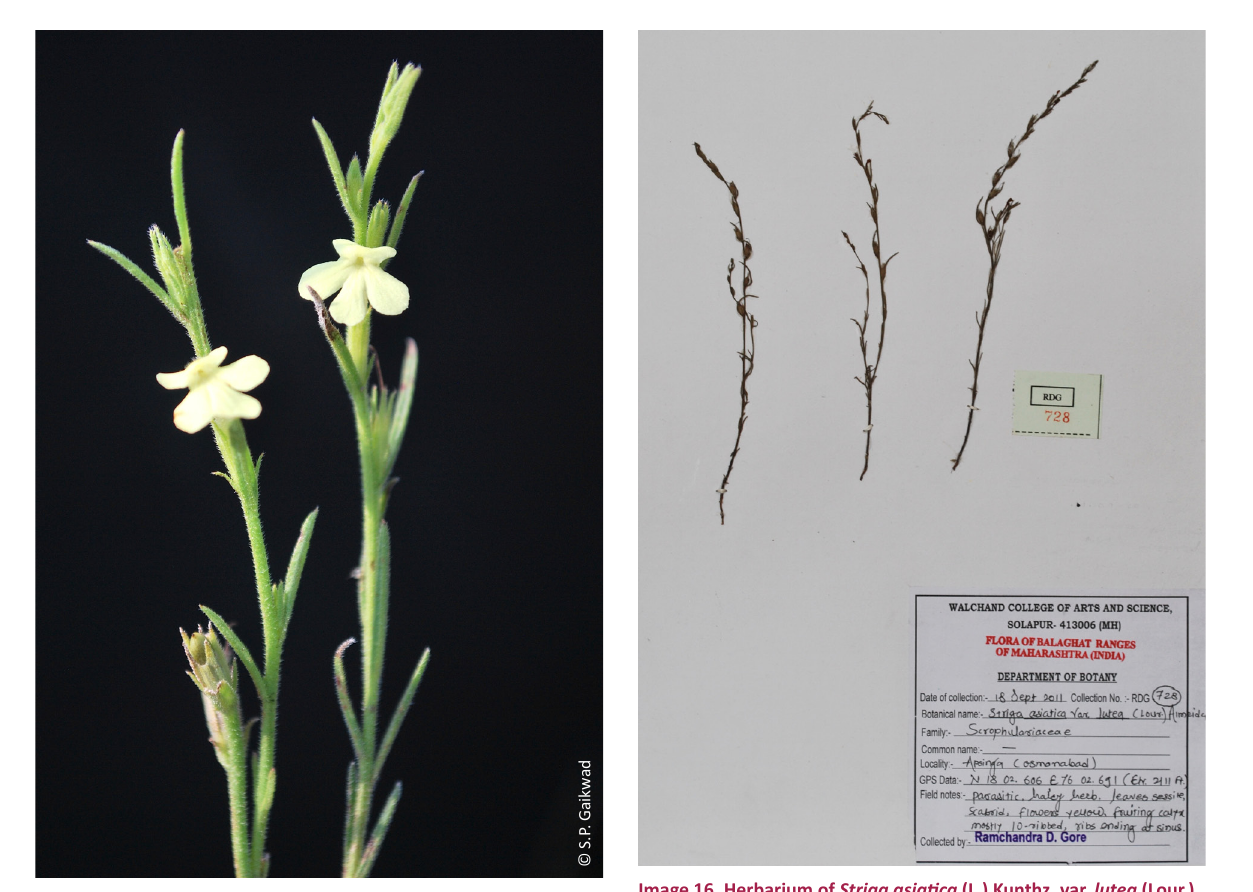
Image 15. Striga asiatica (L.) Kunthz. var. lutea (Lour.) Almeid